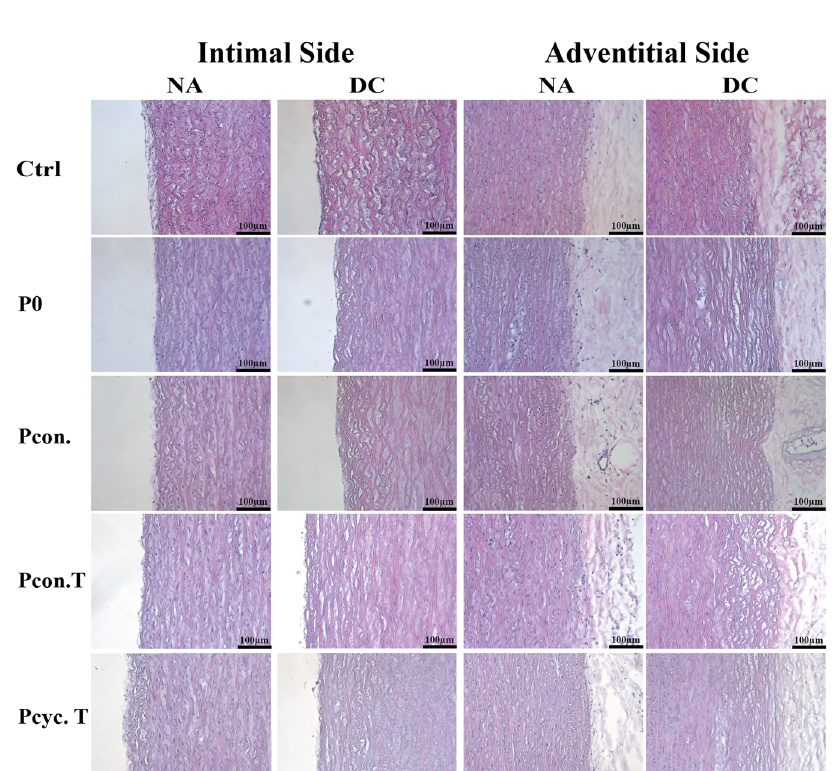
Fig. 3 Representative images of DAPI stained aortic tissue. In ( A ) representative images of DAPI stained aortic tissues are shown (as black and white images; magni fi cation ×5; scale bar is 500 µm). Red lines are labeling the three main areas: decellularized, disintegrated and not decellularized. Images in ( B ) were taken at a magni fi cation of ×20 (scale bar is 100 µm). Green lines are depicting the completely decellularized area at the adventitial and intimal side. NA native tissue; DC decellularized tissue: IS intimal side; AS adventitial